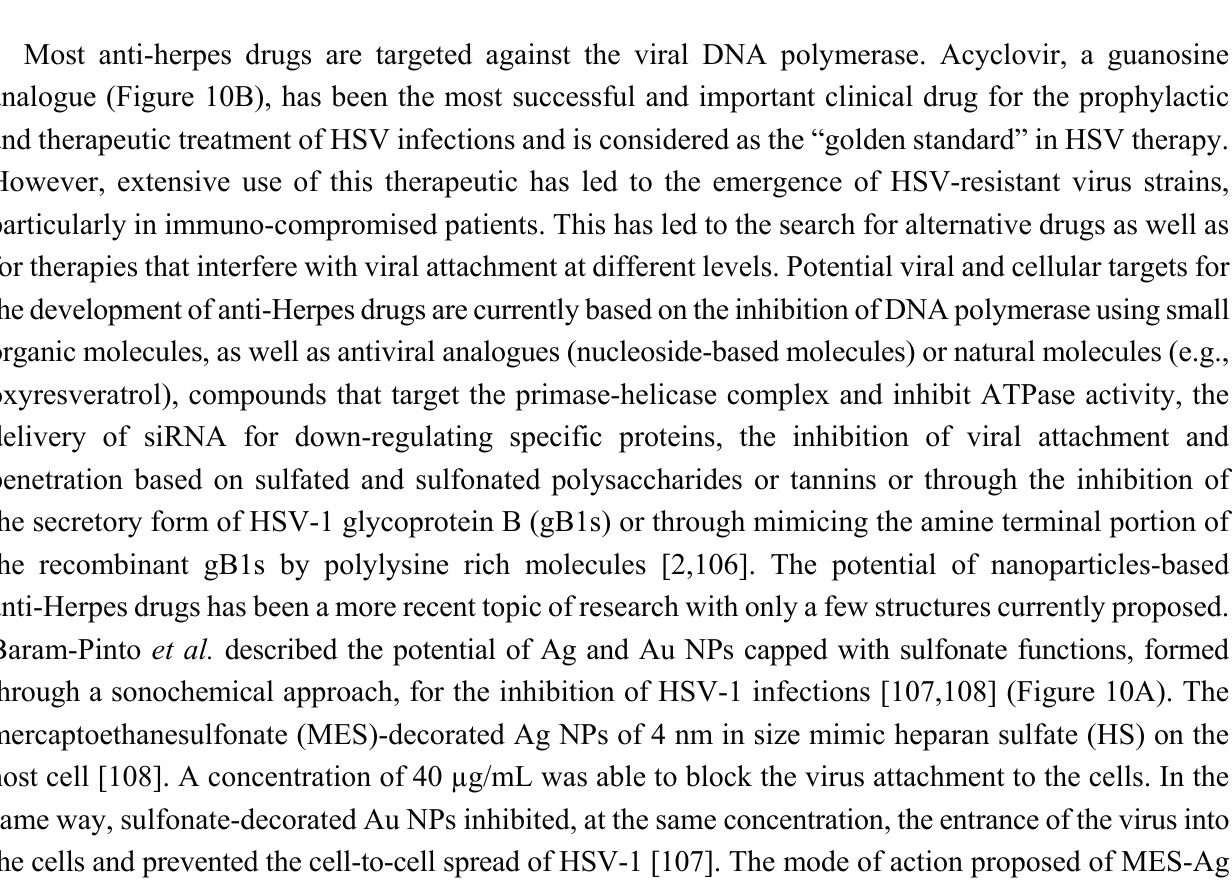
Figure 9. ( A ) HSV virion; ( B ) Entry mode of HSV into cells